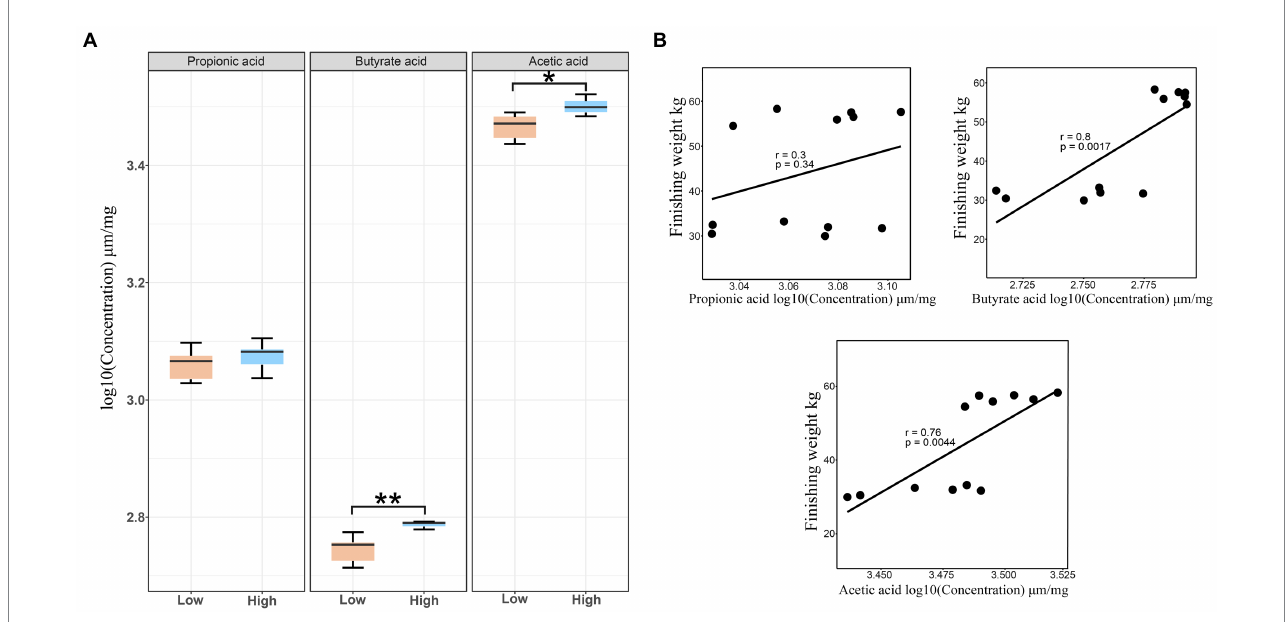
FIGURE 6 Stool short-chain fatty acid concentrations in low and high finishing weight pigs and their correlations with finishing weight. (A) The comparisons of fecal short-chain fatty acid levels between low and high finishing weight pigs. (B) The correlations between stool short-chain fatty acid levels and finishing weight. “*” and “**” represents for FDR adjusted p < 0.05 and p < 0.01, respectively.